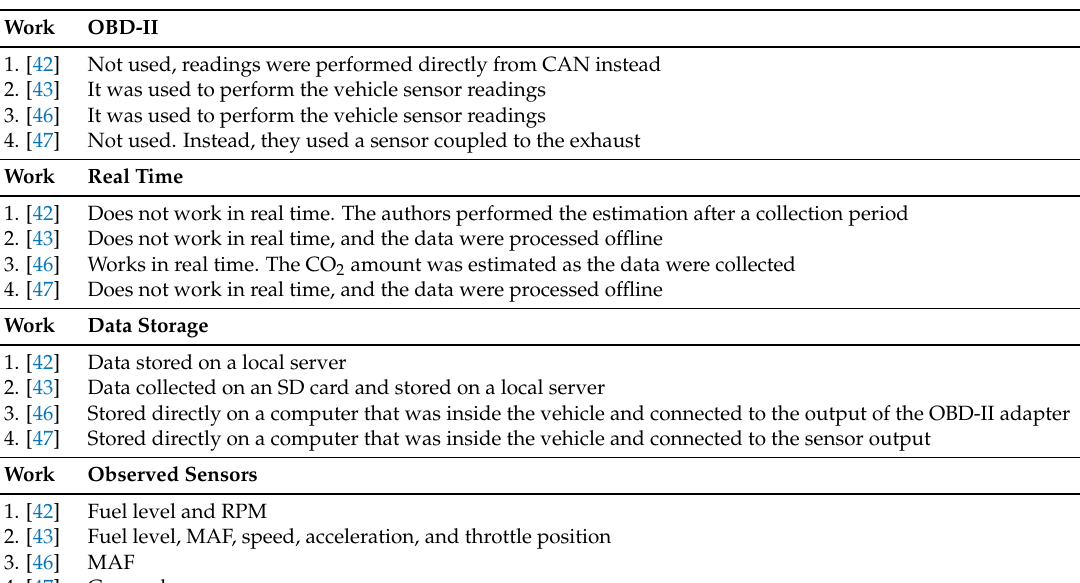
Table 1. Summary of related